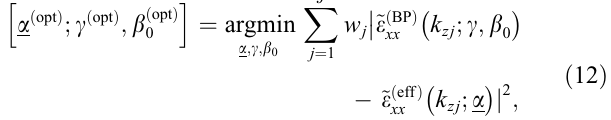
Figure 2. (a), (b) Effective constitutive parameters at the design angular frequency x = x 0 . Red-dashed curves represent the opti- mized blueprints, obtained from equations (4) and (6), with ~ R ¼ 0, c ¼ (cid:2) 0 : 478 k (cid:2) 2 , and b 0 = 0.46 k 0 . Blue-solid curves pertain to the 0 nonlocal effective model of the synthesized multilayered metama- terial [four-layer unit cell shown in the inset of panel (b)] with e 1 = 7.089, e 2 given in equation (9) (with e 2 = (cid:2) 1.104 and j 2 = 0.0365), e 3 = 3.35, e 4 = (cid:2) 1.957, d 1 = 0.252 k 0 , d 2 = 0.0815 k 0 , d 3 = 0.102 k 0 , d 4 = 0.0648 k 0 . The parameter match- ing is enforced at k x = 0 and within the (yellow-shaded) range 0.9 b 0 (cid:4) k z (cid:4) 1.1 b 0